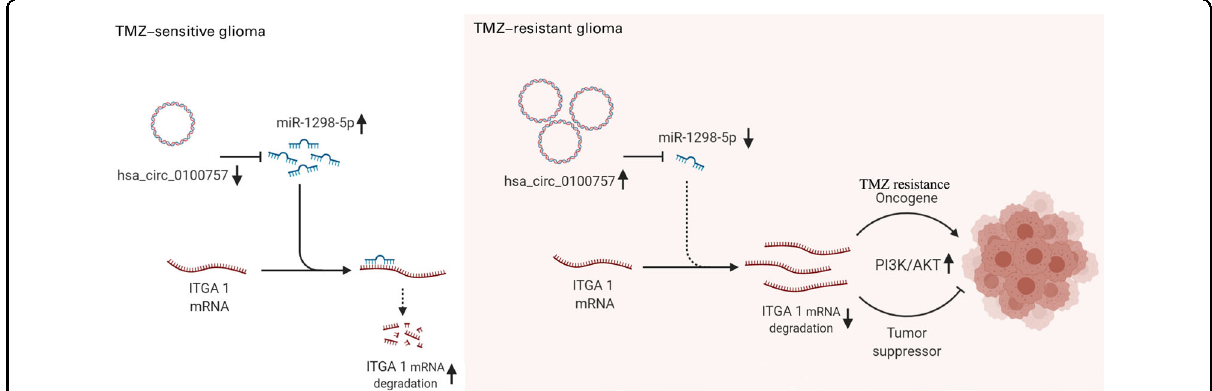
Fig. 7 The mechanism diagram of hsa_circ_0110757 inducing TMZ resistance. Hsa_circ_0110757 is overexpressed in TMZ-resistant glioma and can effectively sponge hsa-miR-1298-5p to increase the expression of ITGA1. ITGA1 excites the PI3K/AKT signaling pathway, inhibits apoptosis and promotes TMZ resistance in glioma